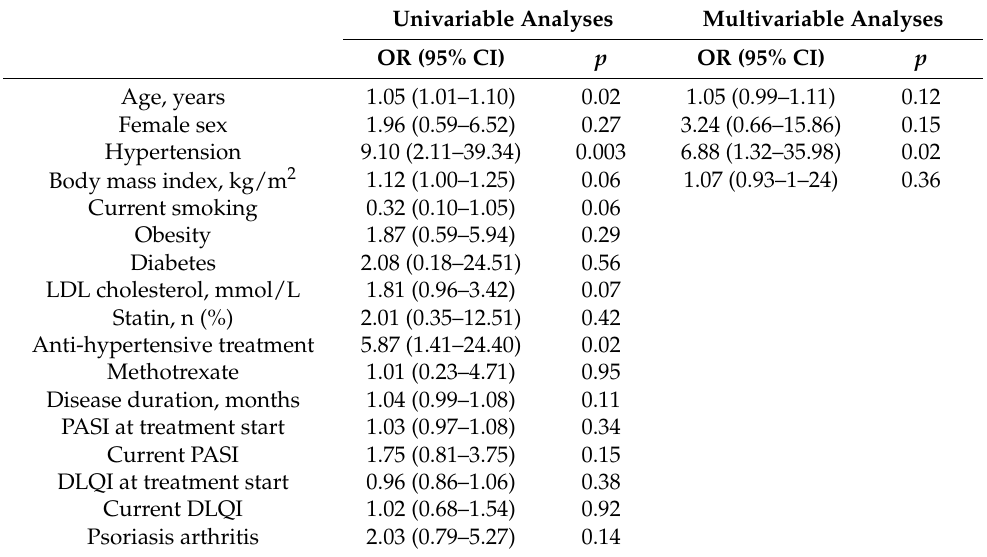
Table 4. Associations of subclinical cardiac organ damage in the psoriasis group. Univariable Analyses Multivariable